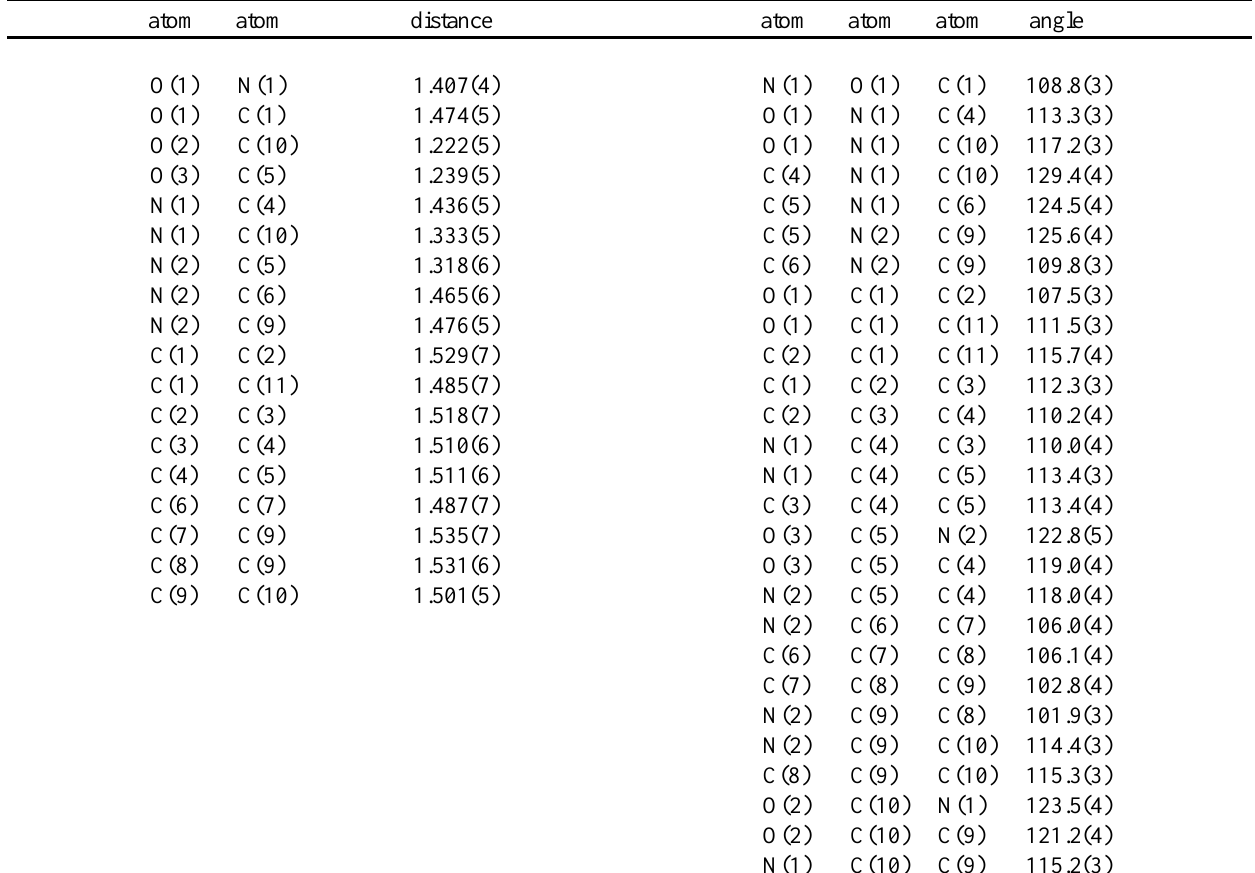
Table 1. Dimensional parameters for 8